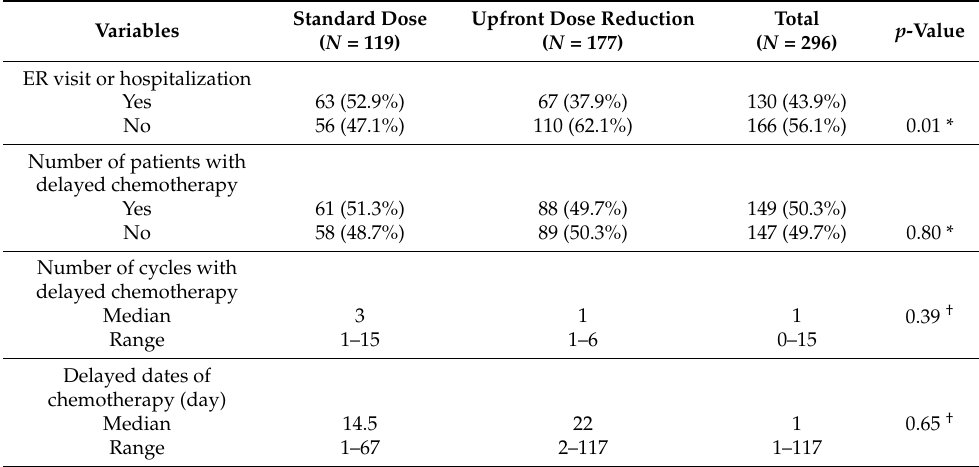
Table 6. Tolerance of and compliance with first-line palliative chemotherapy.